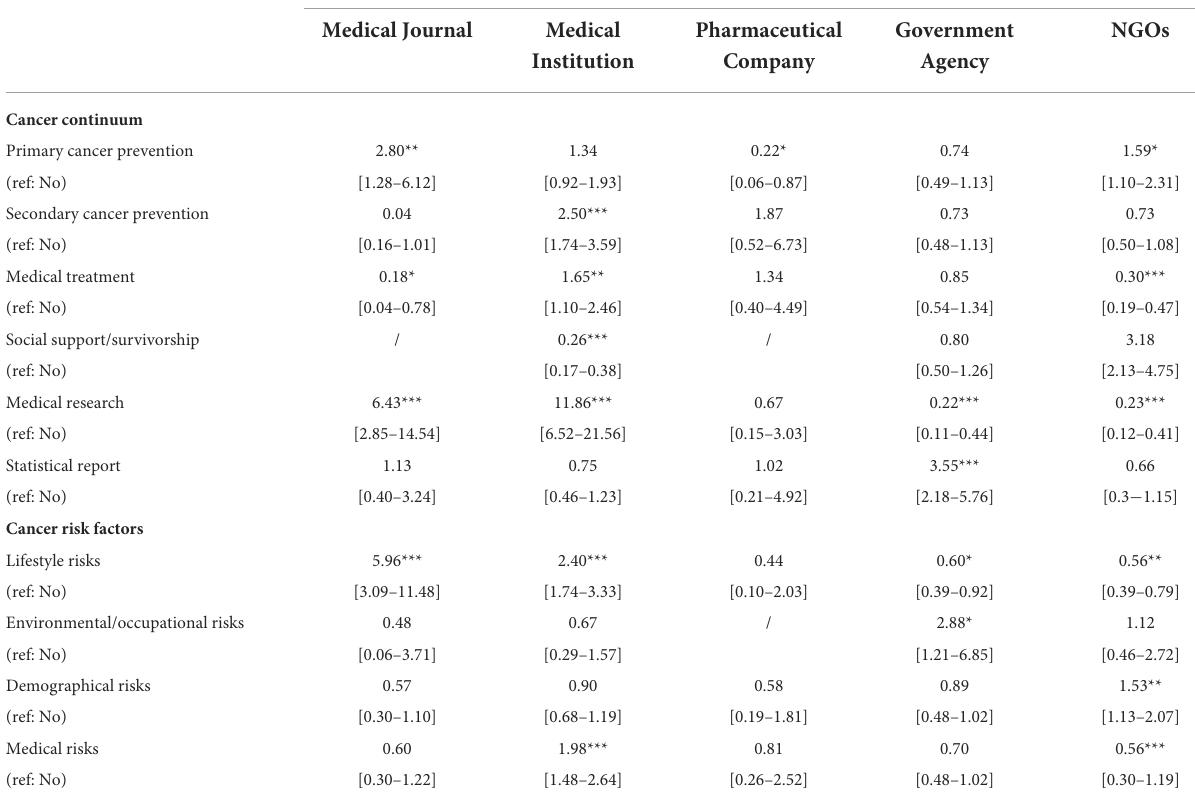
TABLE 1 Binary logistic regression analysis: associations between news factors and the invitation of news sources ( N =